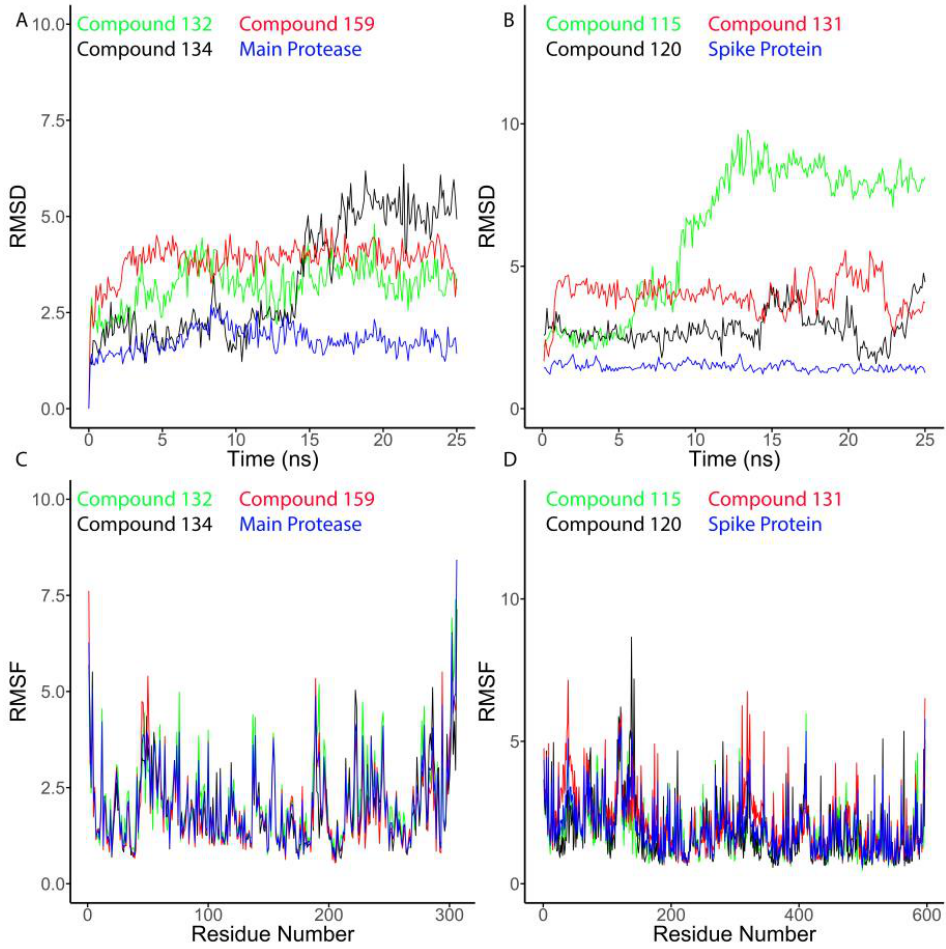
Figure 8. Analysis of the molecular dynamics (MD) simulations for top scoring compounds from Aloe genus. ( A ) RMSD analysis for M pro and the ligands 132, 134 and 159 . ( B ) RMSD analysis for spike glycoprotein and the ligands 115 , 120 and 131 . ( C ) RMSF analysis for M pro and the ligands 132 , 134 and 159 . ( D ) RMSF analysis for spike glycoprotein and the ligands 115 , 120 and 131 . With respect to SARS-CoV-2 spike glycoprotein, both compounds 120 and 131 were stable inside the binding site during MD simulation, with scoring average RMSDs of 2.81